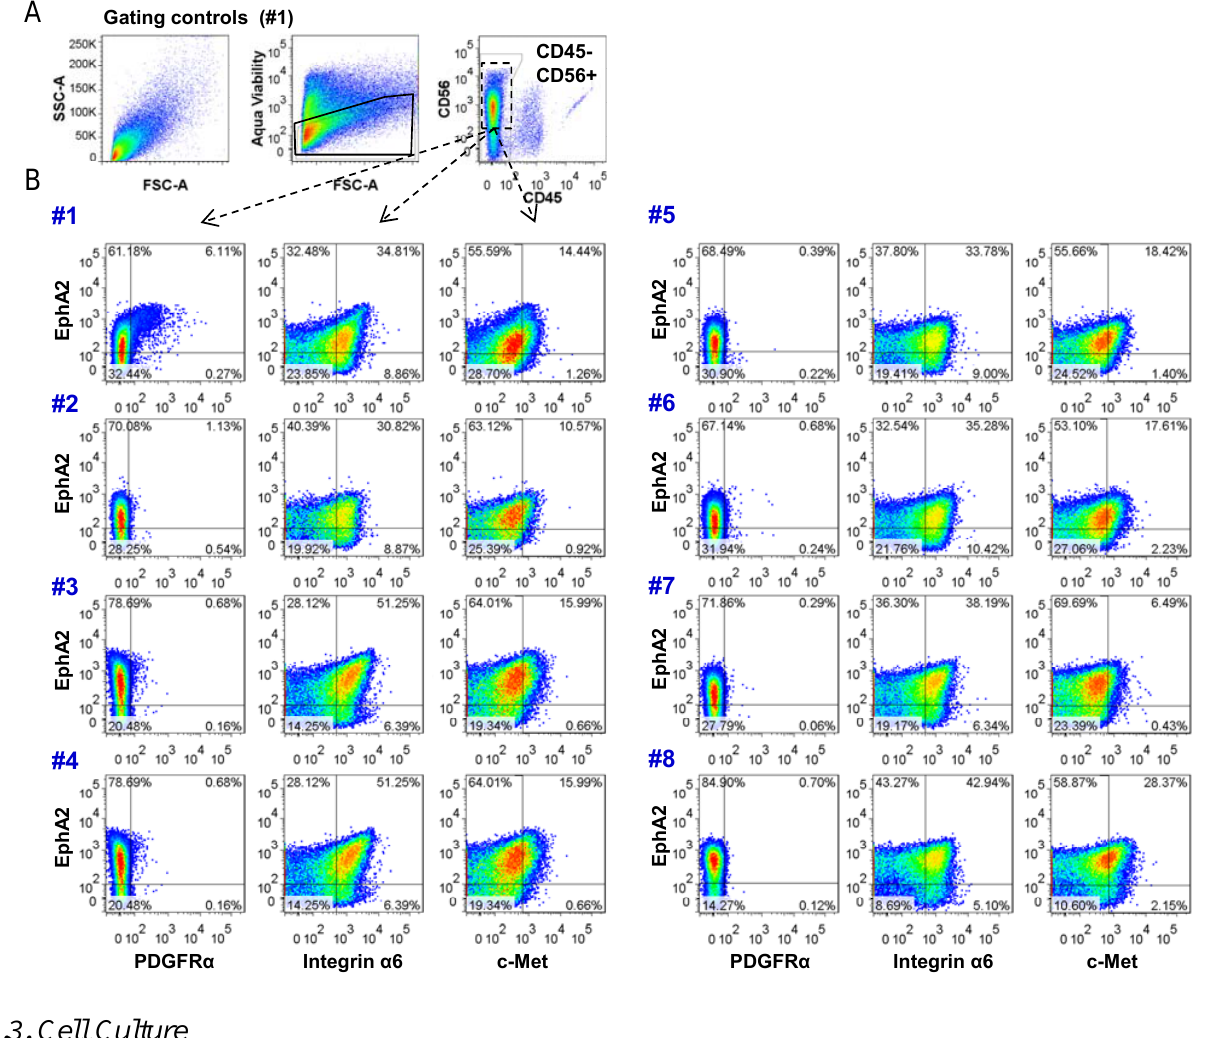
Figure 5. CUSA surgical aspirate can be used to analyze tumor heterogeneity using multiplex flow cytometry. ( a ) Cells staining negative for aqua viability dye were gated and plotted to examine the NCAM/CD56 positive CD45 negative populations; ( b ) Multiplex flow cytometric analysis of fresh CUSA-isolated surgical tissue aspirate collected immediately after surgery and processed and stained as described in materials and